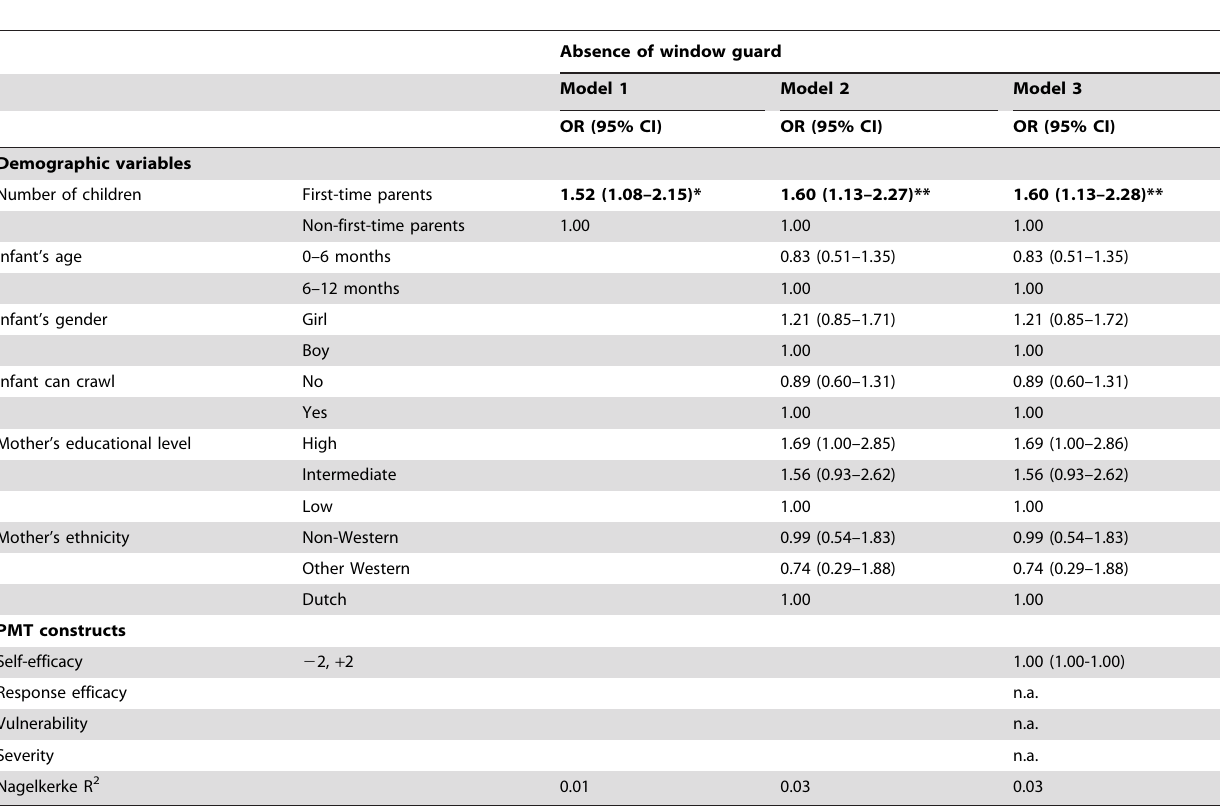
Table 5. Odds ratios (OR), 95% confidence intervals and explained variance (Nagelkerke R 2 ) from multiple logistic regression analyses with reported absence of window guard as dependent variable and number of children (Model 1), other demographic variables (Model 2) and Protection Motivation Theory (PMT) variables (Model 3) as independent factors in a subgroup of parents with windows that could be opened in their house